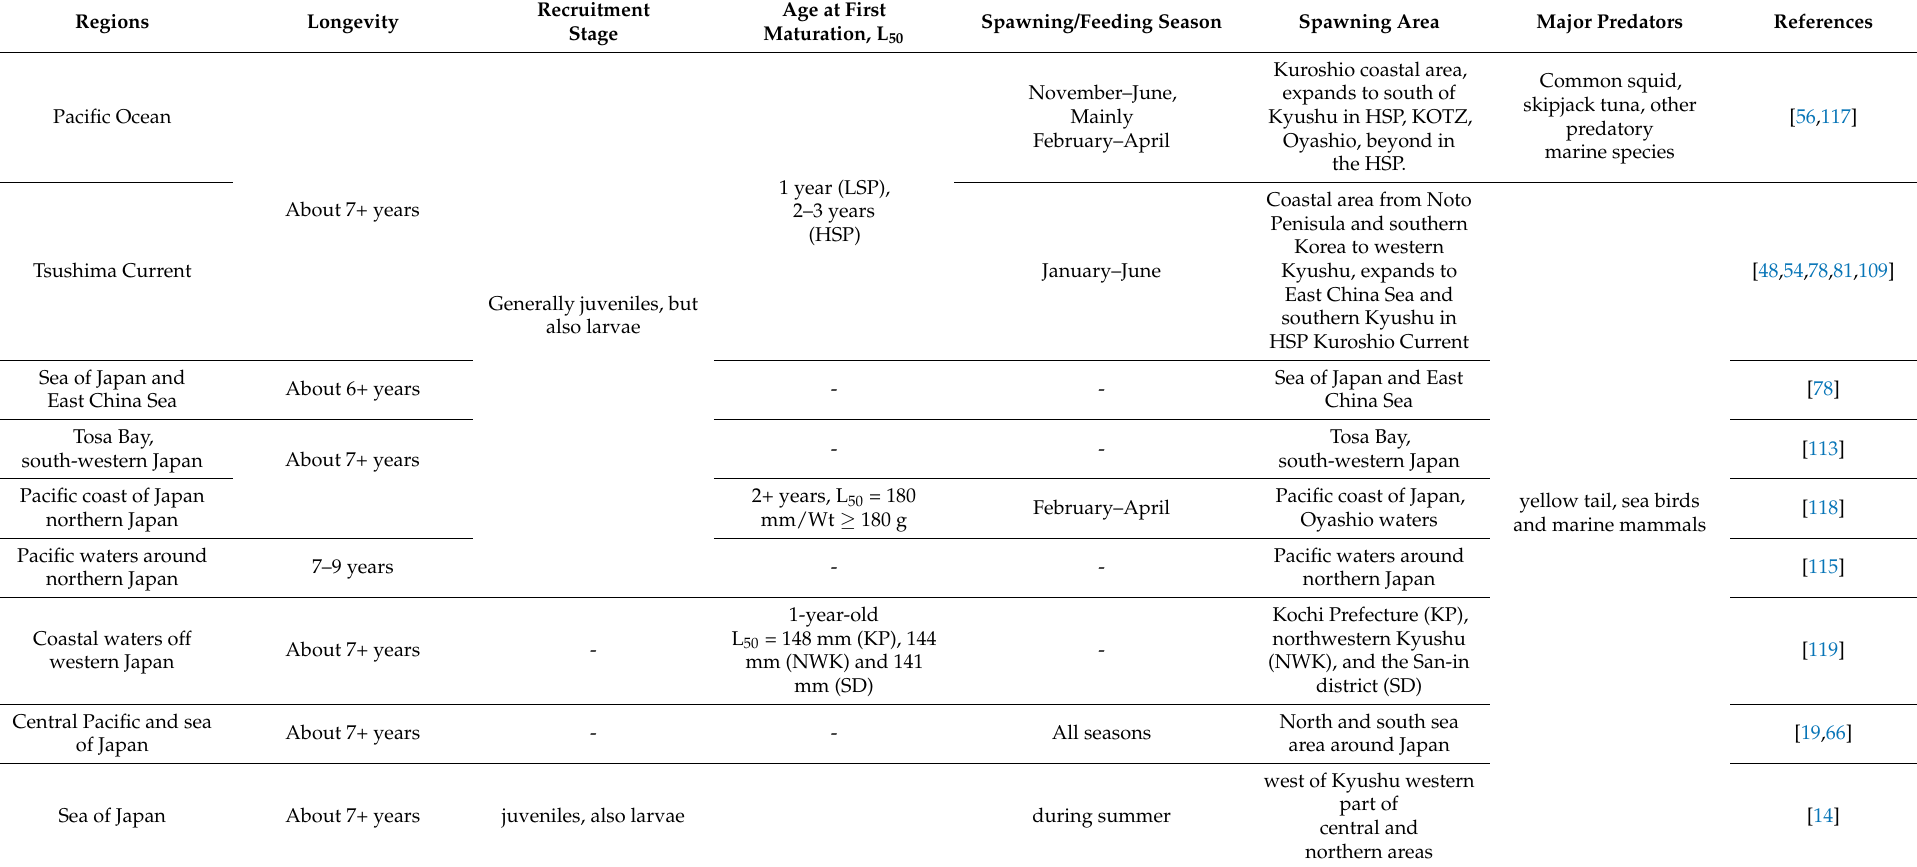
Table 3. Summary of ecological characteristics of Japanese sardine ( Sardinops melanostictus ). NB: HSP: high stock period, KOTZ: Kuroshio Oyashio transition zone, LSP: low stock